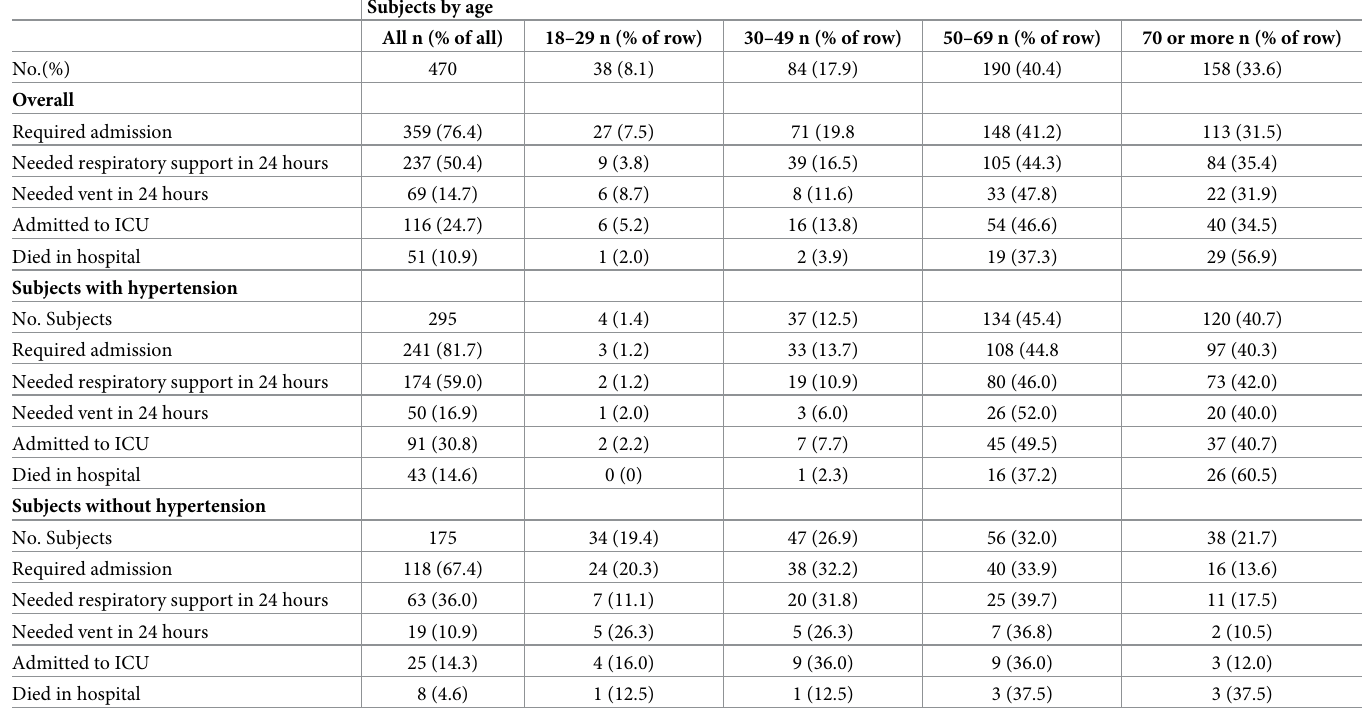
Table 3. Outcomes of COVID subjects admitted to the hospital or emergency room, total and by age